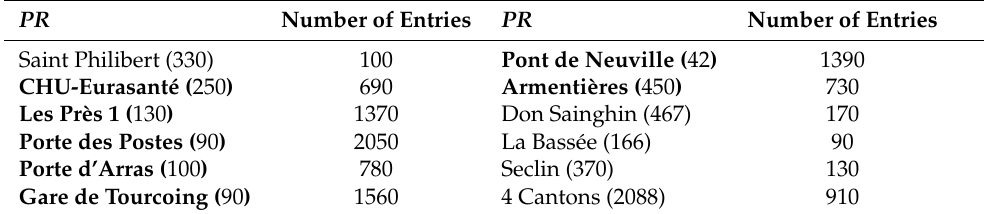
Table 2. Number of cumulative entries for the 12 PR s of MEL between 7:00 a.m. and 9:00 a.m.